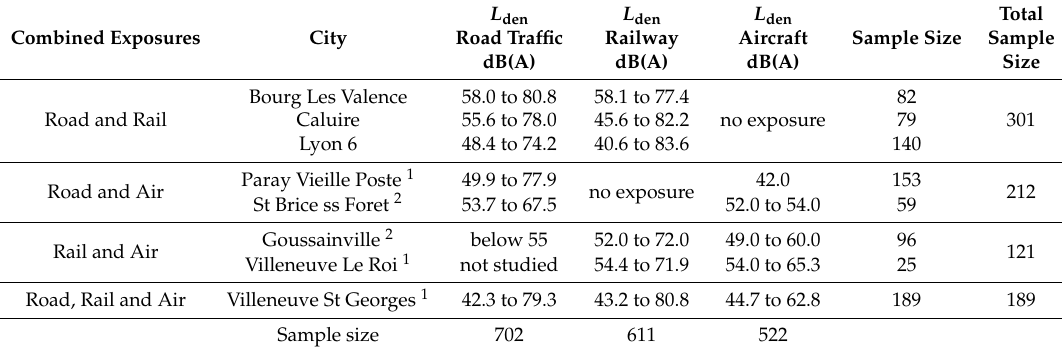
Table 1. Noise exposure given in L den (dB(A)) per noise source and sample size of areas in cities under study during the survey ([14]). Road: Road traffic, Rail: Railway and Air: Aircraft. 1 : city exposed to Orly airport noise, 2 : city exposed to Roissy-Charles-de-Gaulle airport noise.